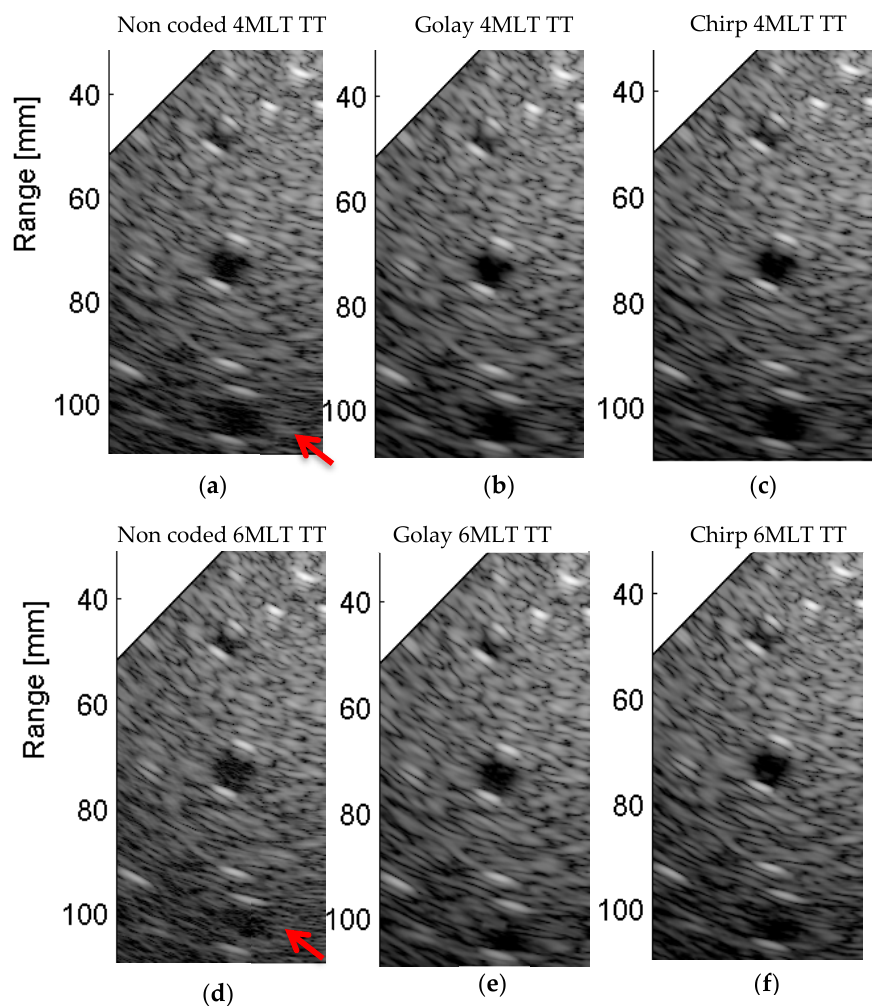
Figure 12. Zoomed in tissue phantom images of the 4MLT and 6MLT schemes using ( a , d ) non-coded; ( b , e ) Golay-coded excitation; or ( c , f ) chirp-coded excitation. TT apodization was applied on both transmit and receive. TT: Tukey ( α = 0.5)-Tukey ( α = 0.5) apodization scheme. A dynamic range of 55 dB was used. The arrows in panel ( a ) and ( d ) point the areas in which the non-coded MLT schemes started to lose SNR.